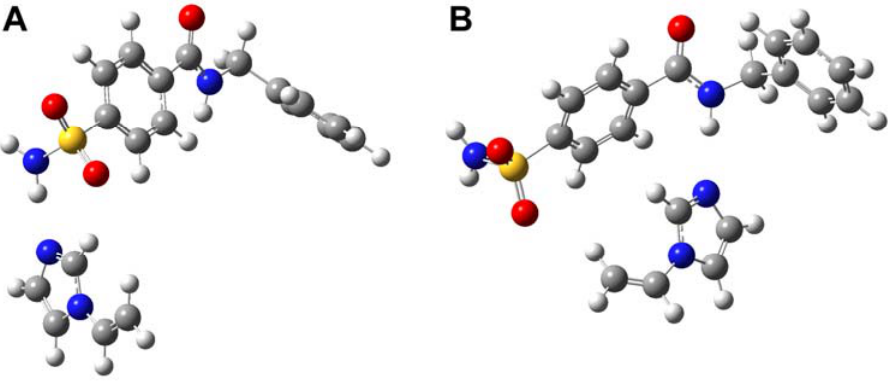
Figure 7. Geometrically optimized structures of VIM and template 1 calculated at HF/3- 21G(d) level in a one point interaction via the H-bond of imidazole N-atom of VIM with NH of sulfonamide (A) as well as the H-bond of imidazole N-atom of VIM with NH of central amide moieties